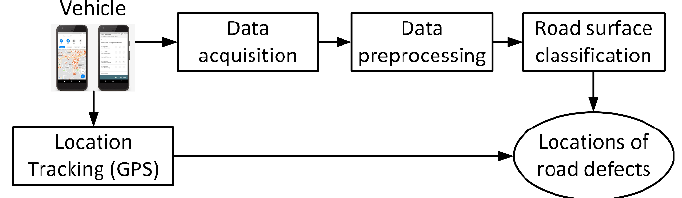
Figure 5. Road surface monitoring with smartphones.